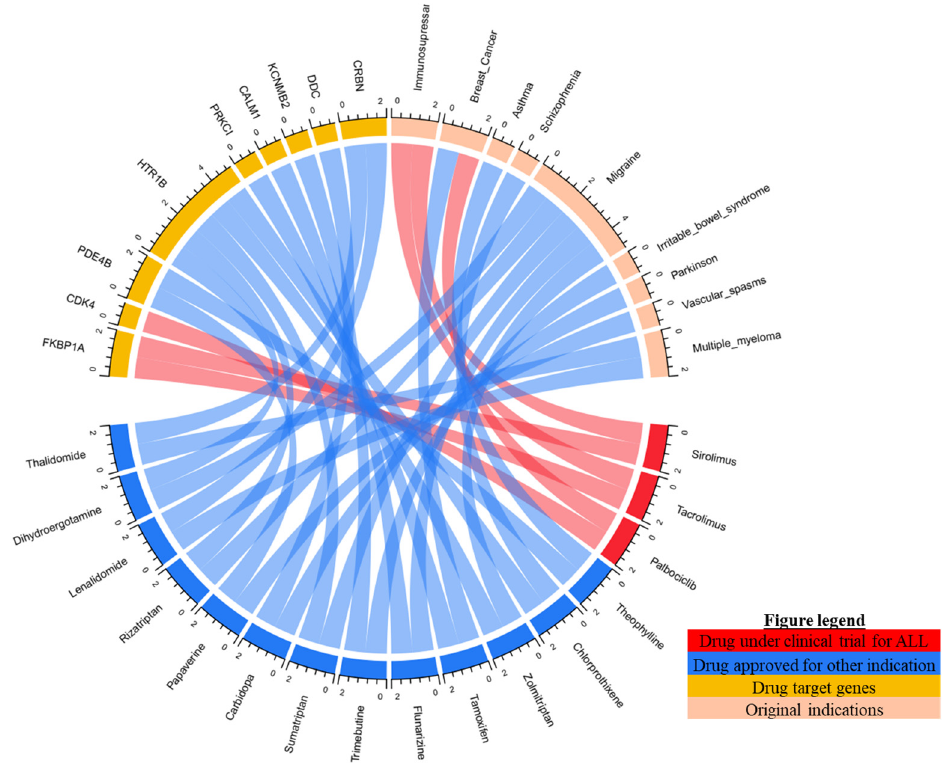
Figure 3. The candidate drugs for acute lymphoblastic leukemia (ALL) are based on CMap analysis.